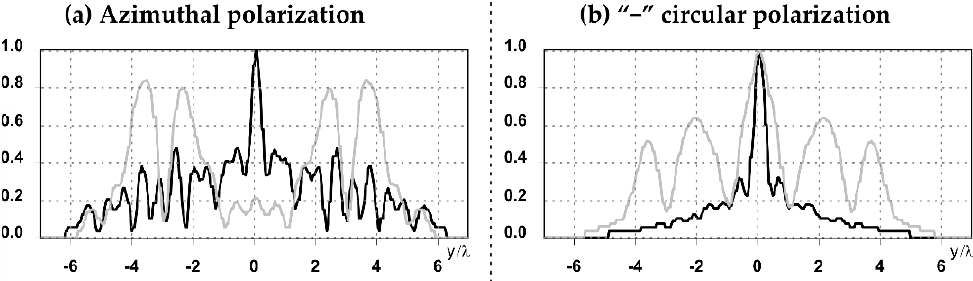
Figure 3. The cross sections on distance z 1 = 0.5 λ , diffractive axicon with NA = 0.95 (black line) and diffractive axicon with NA = 0.25 (gray line): ( a ) azimuthal polarization, ( b ) “ − ” circular polariza- tion.